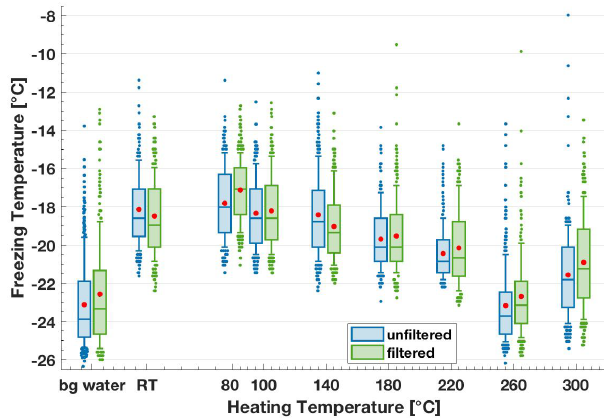
Figure 6. Freezing temperature boxplots of the 200mgCL − 1 lignin solutions directly after heating (blue, unfiltered) and after fil- tering through a sterile syringe filter of 0.22µm, PES membrane, TPP (green, filtered). “Bg water” refers to background water, “RT” refers to room temperature, i.e. 20 ◦ C. Irrespective of the filtering, lignin’s IN activity decreases after a heating treatment of 180 ◦ C or